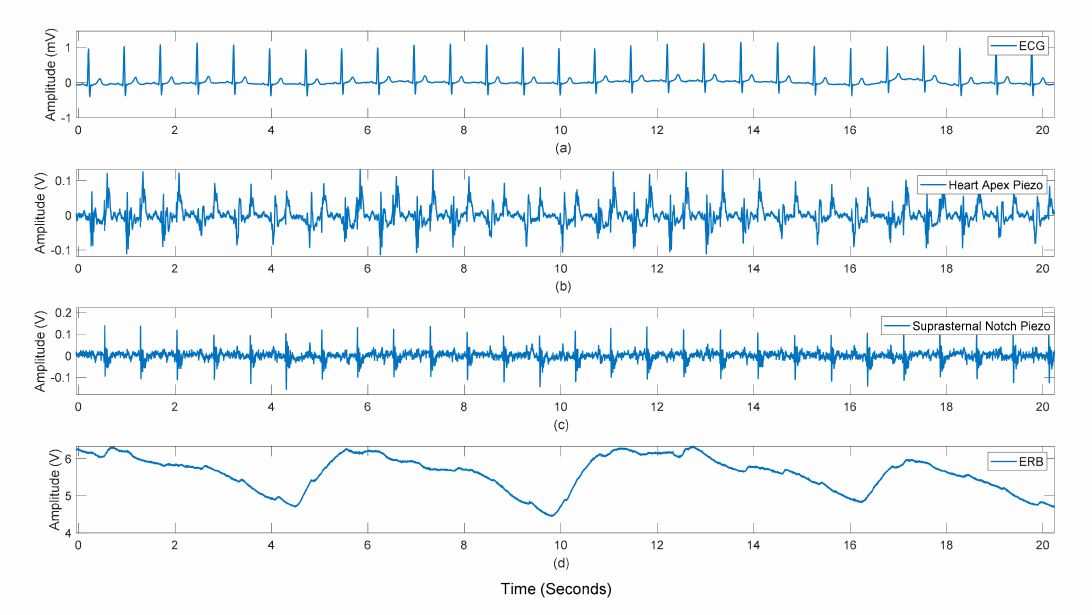
Figure 7. Subject #3 dataset: Raw recordings from ( a ) ECG signal, ( b ) sensor placed on the heart apex ( c ) sensor on the suprasternal notch ( d ) the respiration band around the chest.